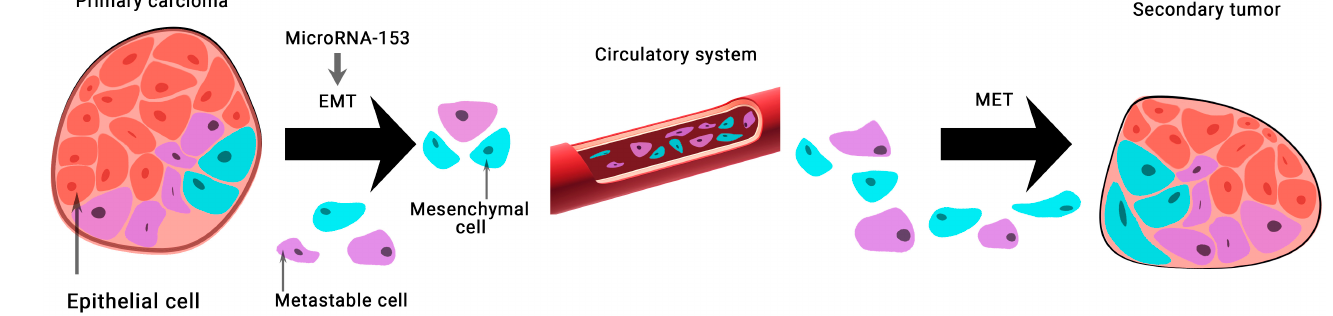
Figure 3. The role of microRNA-153 in carcinogenesis. MicroRNA-153 is involved in epithelial- mesenchymal transition (EMT)-associated signaling pathways that stimulate tumorigenesis, cancer progression, and metastasis. A mesenchymal–epithelial transition (MET) is a reversible biological process that involves the transition from mesenchymal cells to polarized cells called